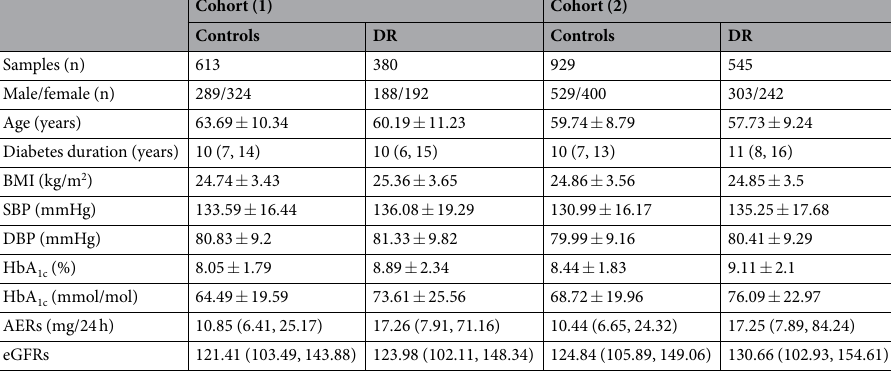
Table 4. Clinical characteristics of the participants in stage 2. Data are n, mean ± SD, or median (interquartile range). AERs = albumin excretion rates; BMI = body mass index; DBP = diastolic blood pressure; DKD = diabetic kidney disease; DR = diabetic retinopathy; eGFR = estimated glomerular filtration rate; HbA 1c = haemoglobin A 1c ; SBP = systolic blood